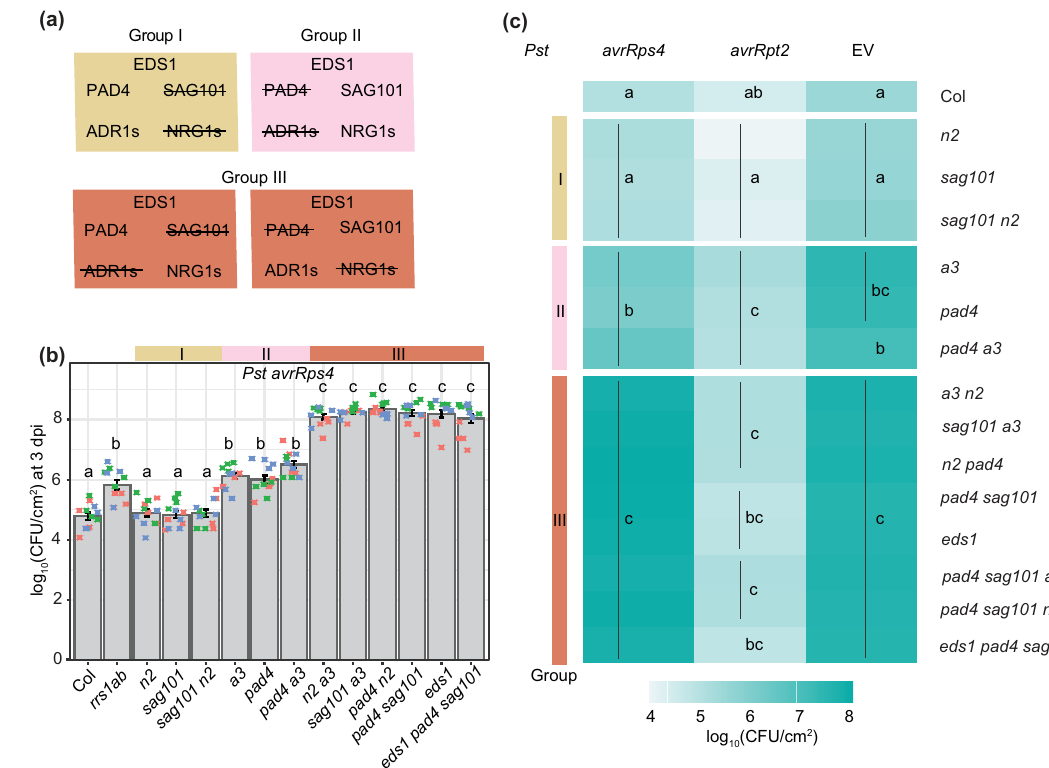
Fig. 1 Distinct PAD4 – ADR1 and SAG101 – NRG1 modules operate in Arabidopsis TNL RRS1 – RPS4 immunity. a Overview of mutants used in ( b ) and ( c ). Group I comprises mutants disabled in SAG101 and/or NRG1 s: sag101 , nrg1.1 nrg1.2 ( n2 ) and sag101 n2 . Group II has mutants in PAD4 and/or ADR1 s: pad4 , adr1 adr1-L1 adr1-L2 ( a3 ) and pad4 a3 . Group III is composed of cross-branch combinatorial mutants a3 n2 , sag101 a3 , pad4 n2 , pad4 sag101 , sag101 pad4 a3 , sag101 pad4 n2 , eds1 pad4 sag101 . b Growth of Pseudomonas syringae pv. tomato DC3000 ( Pst ) avrRps4 in leaves of Arabidopsis Col-0 (Col) and indicated mutants at 3 days